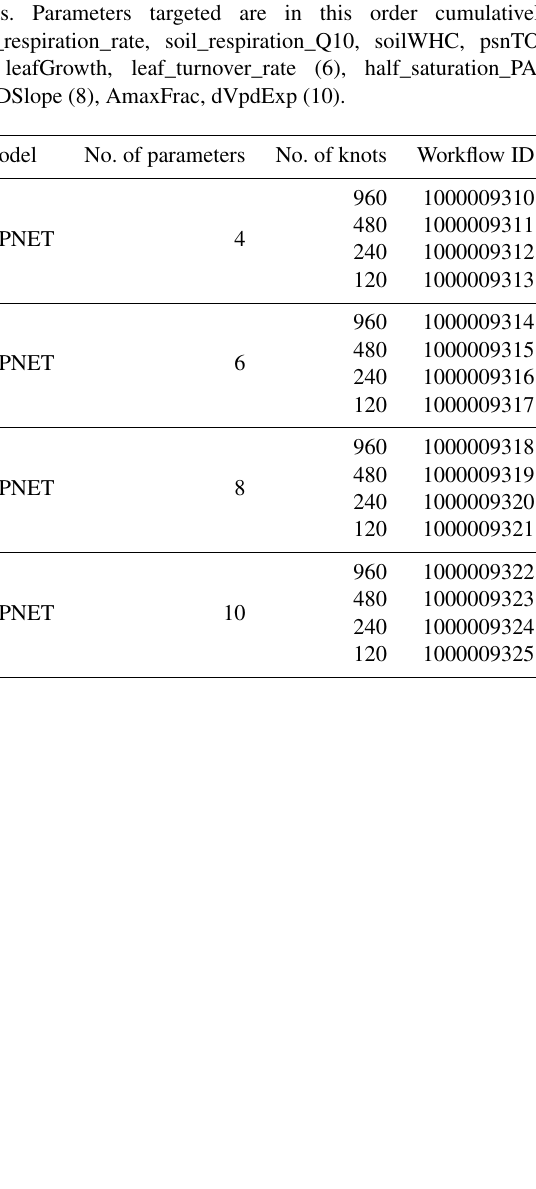
Table A7. Links to the workflow IDs. The input–output files as-